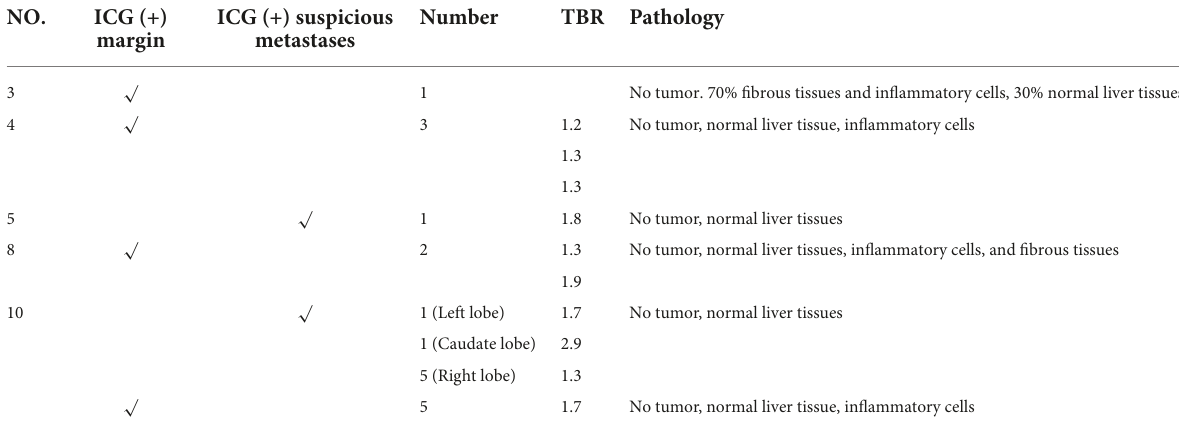
TABLE 4 Number, TBR value, and histopathology of ICG (+) lesions.